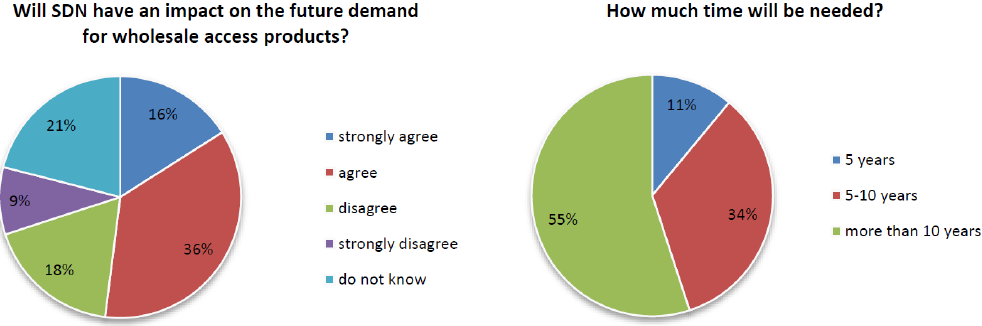
Figure 4. Results of the 2015 EC public consultation on SND/NFV impacts on access services.